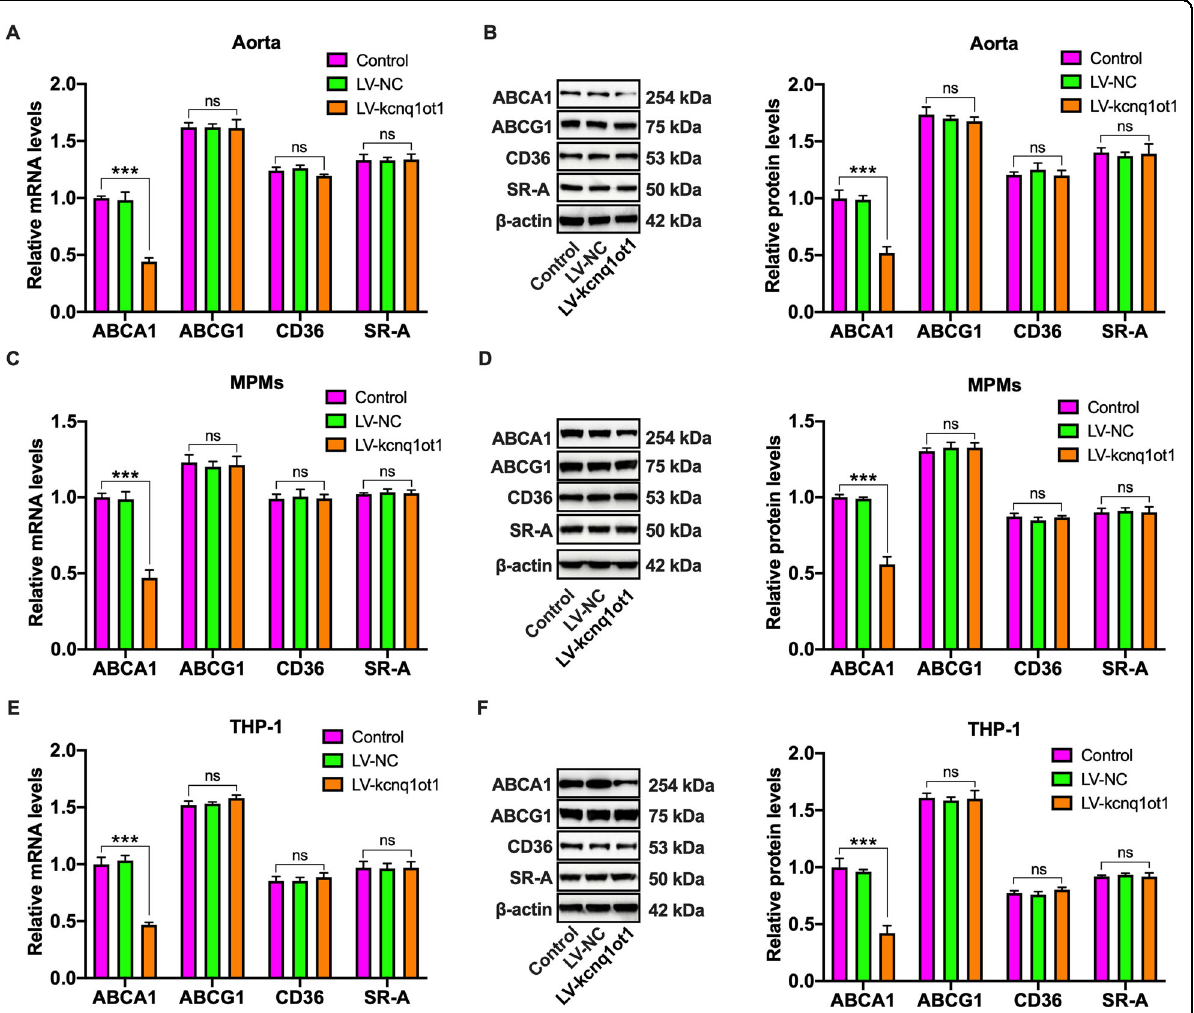
Fig. 4 Effects of kcnq1ot1 on cholesterol transporter and receptor expression. A, B The mRNA and protein levels of ABCA1, ABCG1, CD36, and SR-A in the aorta from apoE − / − mice were assayed by qRT-PCR and western blot, respectively ( n = 10). C , D qRT-PCR and western blot analyses of ABCA1, ABCG1, CD36 and SR-A expression in MPMs from apoE − / − mice ( n = 5). E , F After treatment of THP-1 macrophages with PBS, LV-NC or LV- kcnq1ot1 for 72 h, both qRT-PCR and western blot were employed for detection of ABCA1, ABCG1, CD36, and SR-A expressions. Data are represented as mean ± SD. *** P < 0.001; ns not signi fi